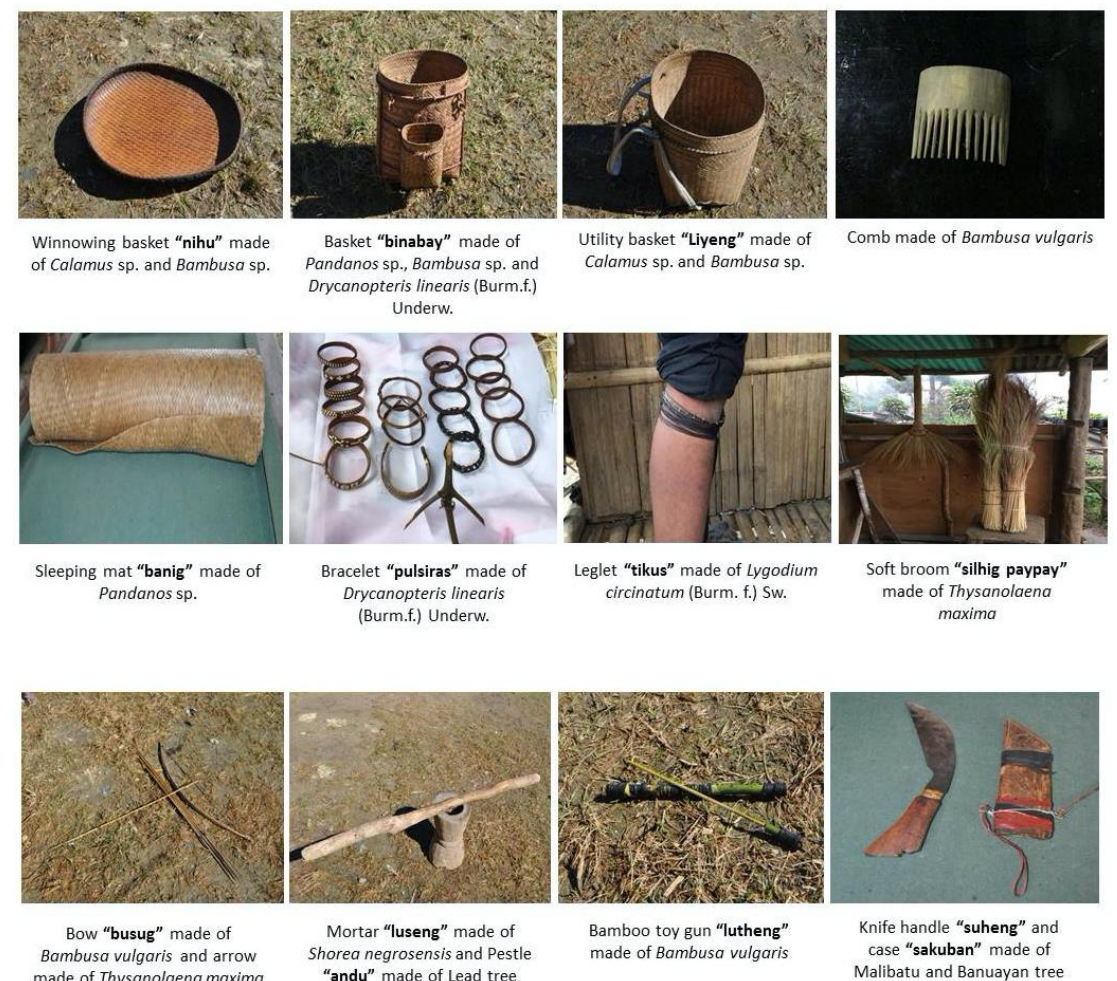
Fig. 6. Collection of traditional handicrafts made by the